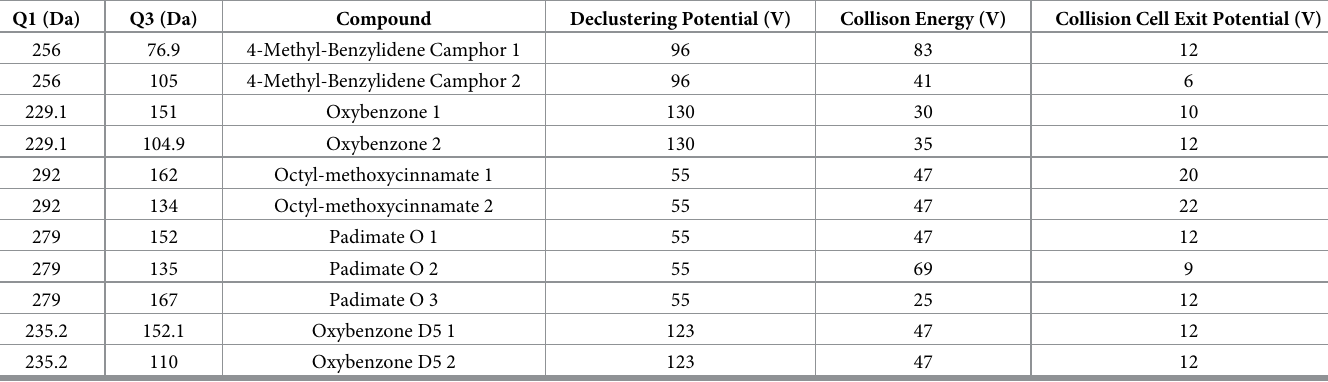
Table 3. Ion transitions and energies used for liquid